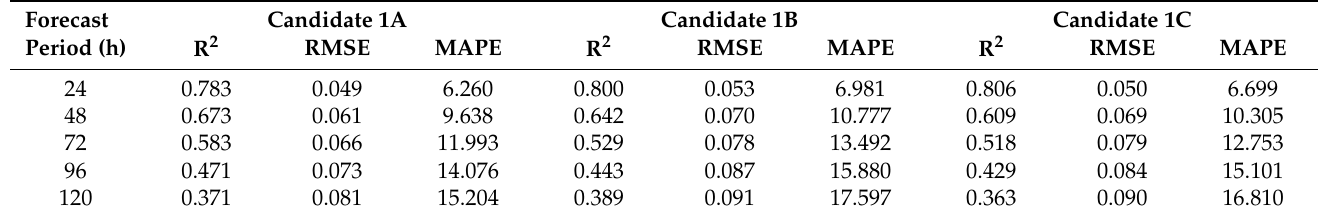
Figure A3. Residuals for the single model candidate 1C. Table A1. The validation results of the single model fitted with MLR. Units of the RMSE and the MAPE were gram per litres and percent respectively.